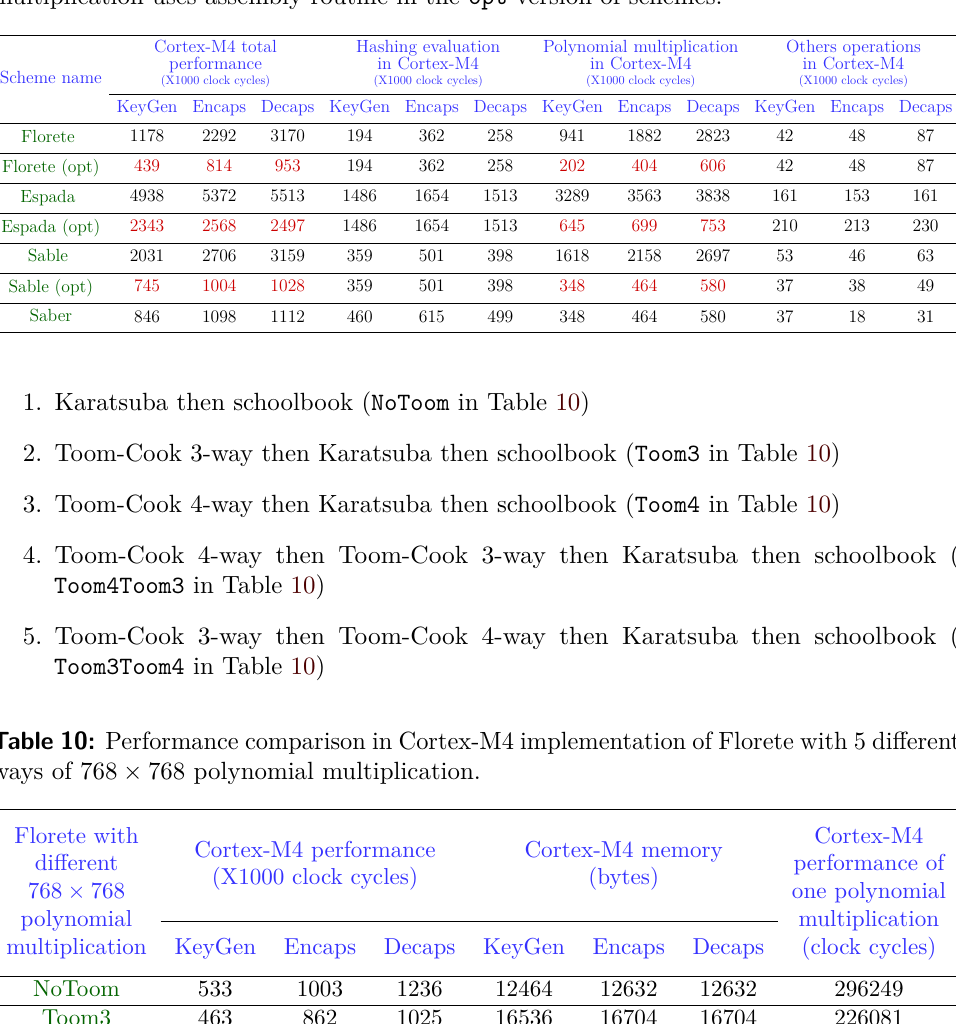
Table 9: Sub-functions performances of our schemes in Cortex-M4. Basic polynomial multiplication uses assembly routine in the opt version of schemes.